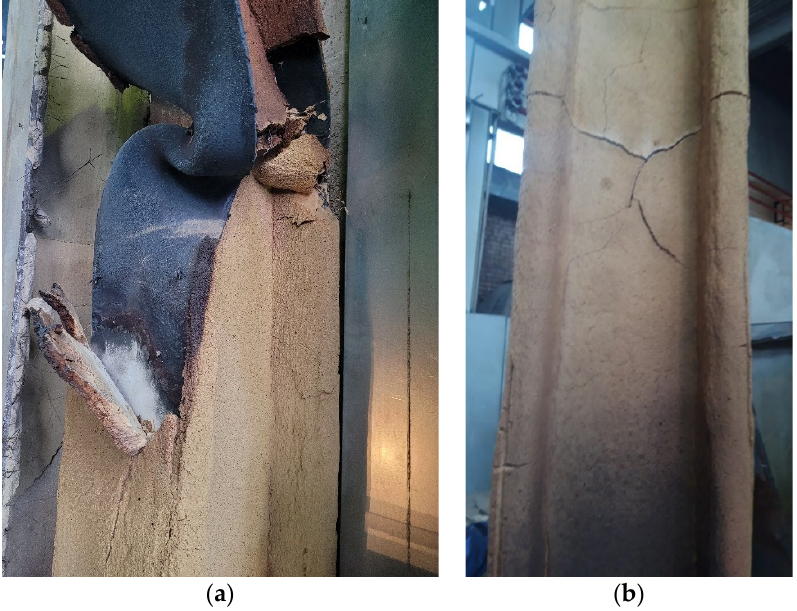
Figure 3. Test sample with coating No. 1.1 ( a ) and with coating No. 1.2 ( b ) after fire